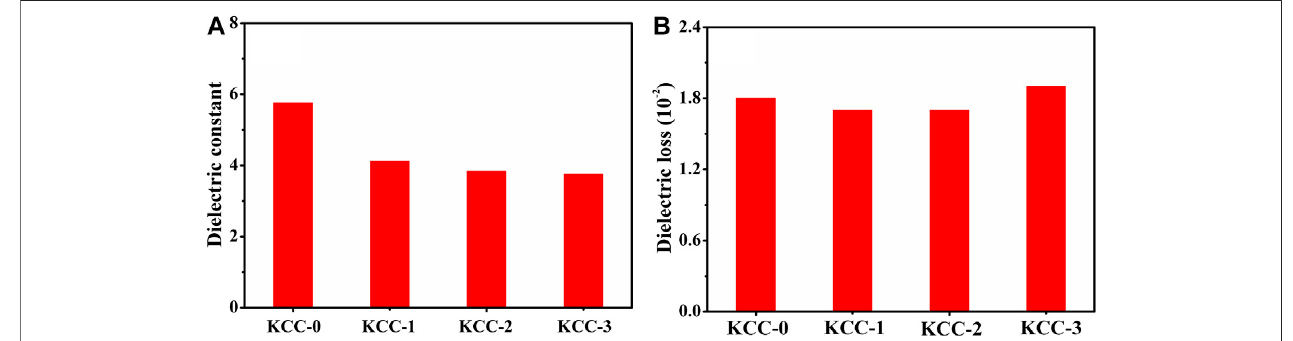
FIGURE 6 | The (A) Dielectric constant and (B) Dielectric loss of the kaolin ceramics.